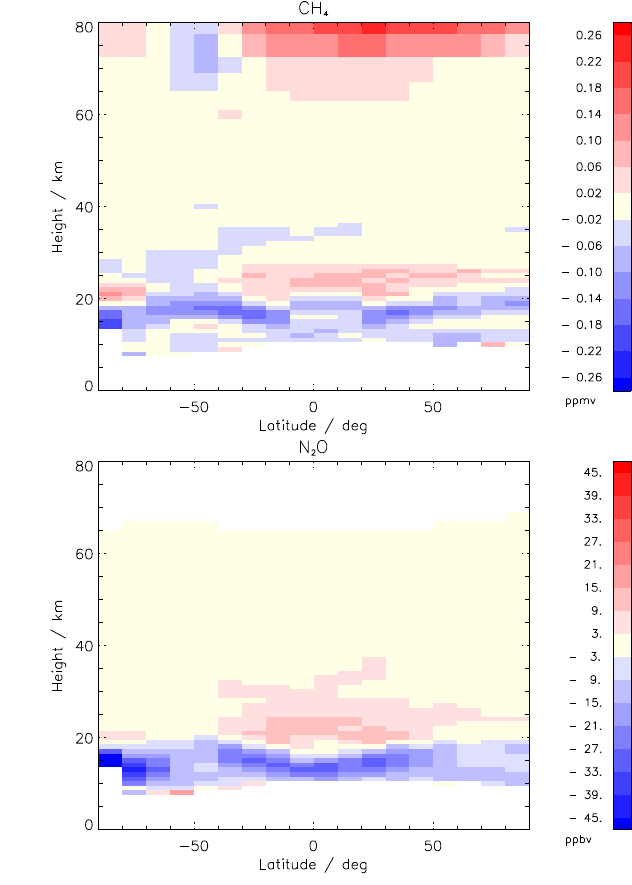
Figure 7. As Fig. 3, but difference retrieval with new selection of 1 Figure 6. Selected microwindows of the setups V5R_CH4_220, 1 microwindows minus reference with old